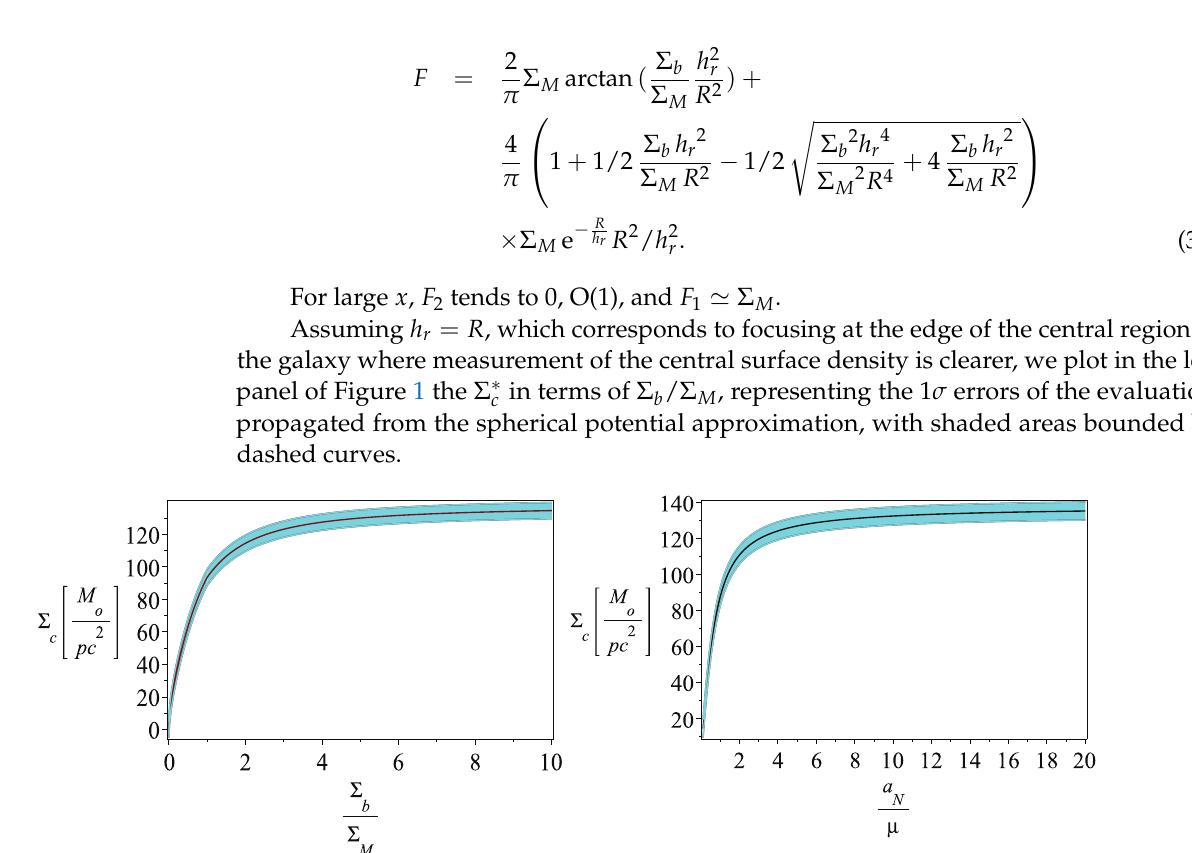
Figure 1. Left panel: the MOND column density in terms of the ratio Σ b / Σ M . Right panel: The MOND column density in terms of the ratio of the acceleration, a N , and µ . In both panels, the shaded regions bounded by dashed curves represent the 1 σ evaluation induced by the approximations described in the